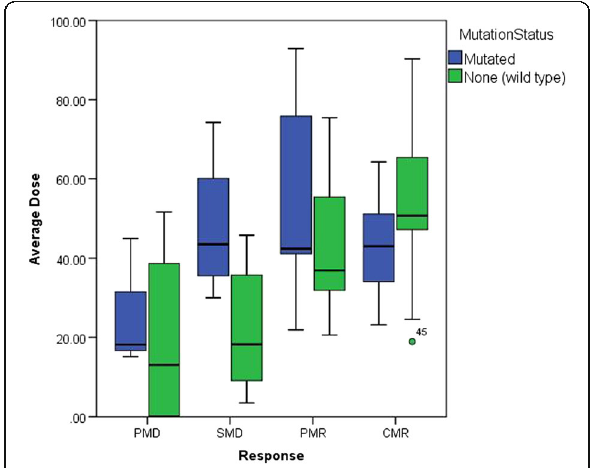
Fig. 5 Average lesion doses corresponding to each response category, separated for lesions of wild type and mutated RAS status. The shaded regions represent the interquartile (IQ) range, with the solid line representing the median value. Mild outliers ( circle ) are points which lie greater than 1.5 times the IQ range from the upper ( 3rd ) or lower ( 1st ) quartile. Extreme outliers ( asterisk ) are points which lie greater than three times the IQ range from the upper ( 3rd ) or lower ( 1st ) quartile